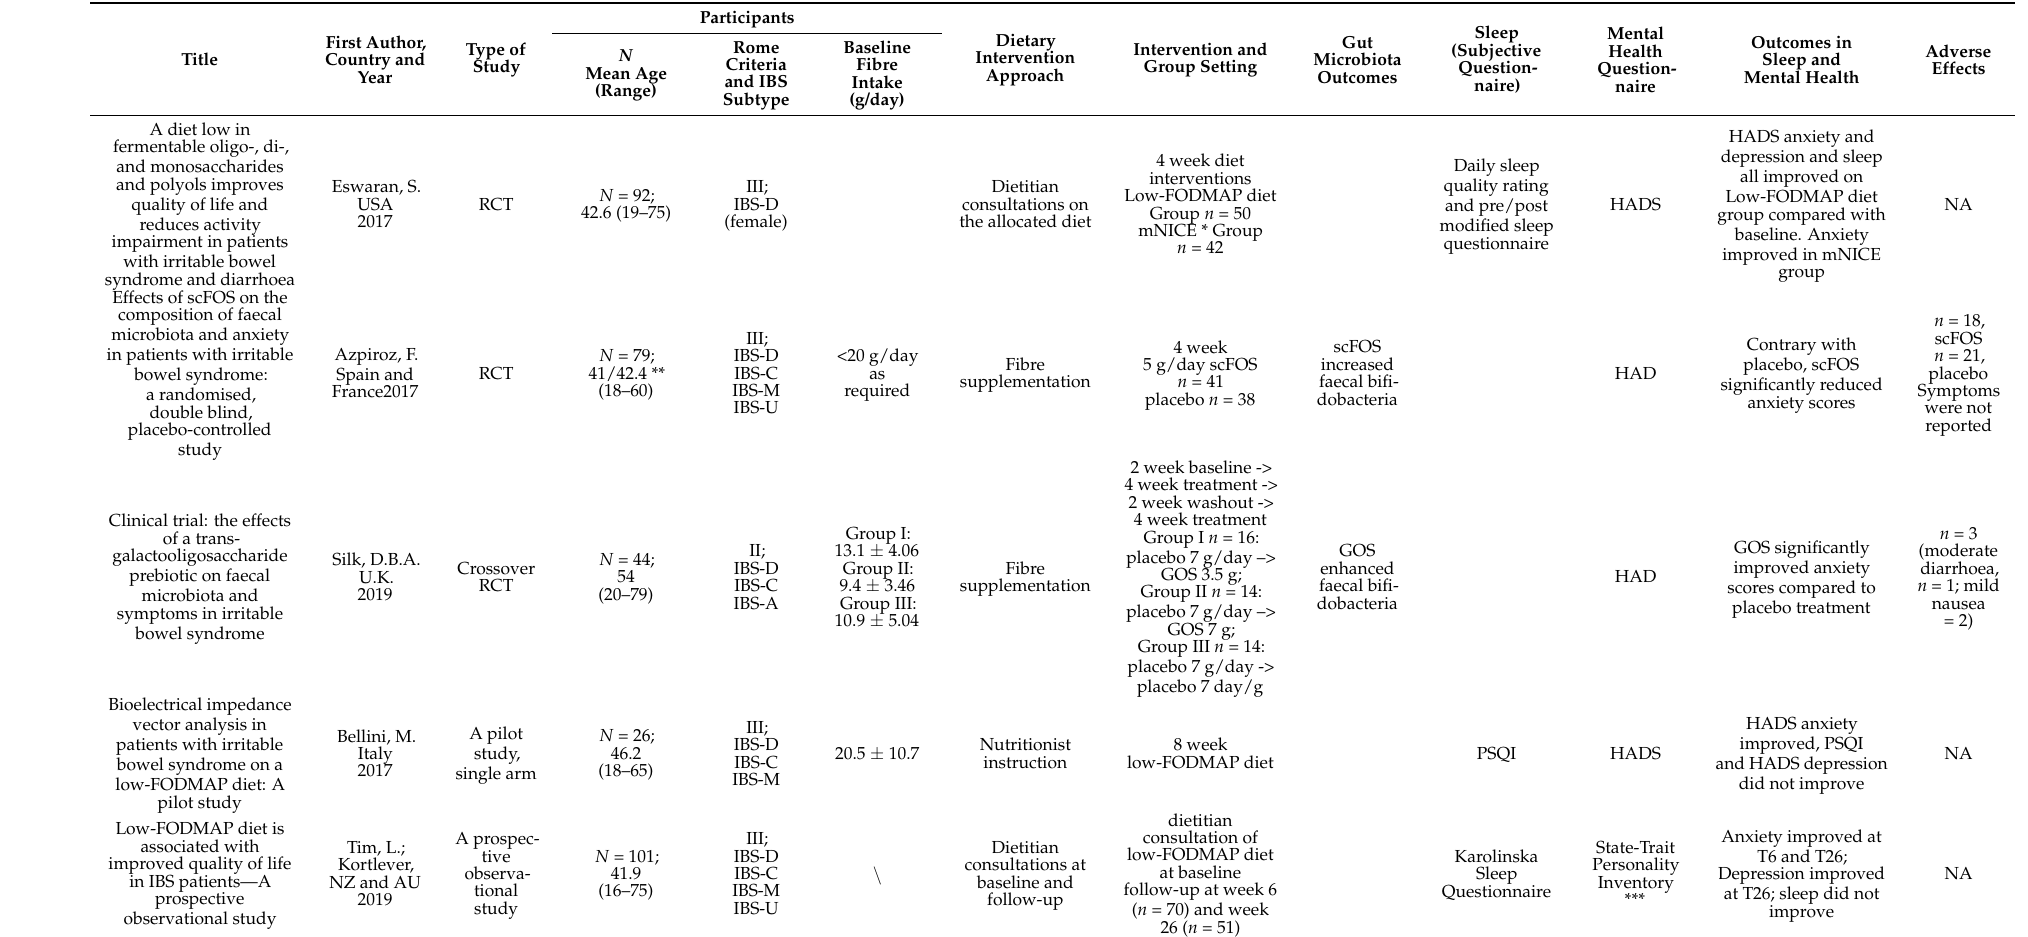
Table 2. Summary and characteristics of included